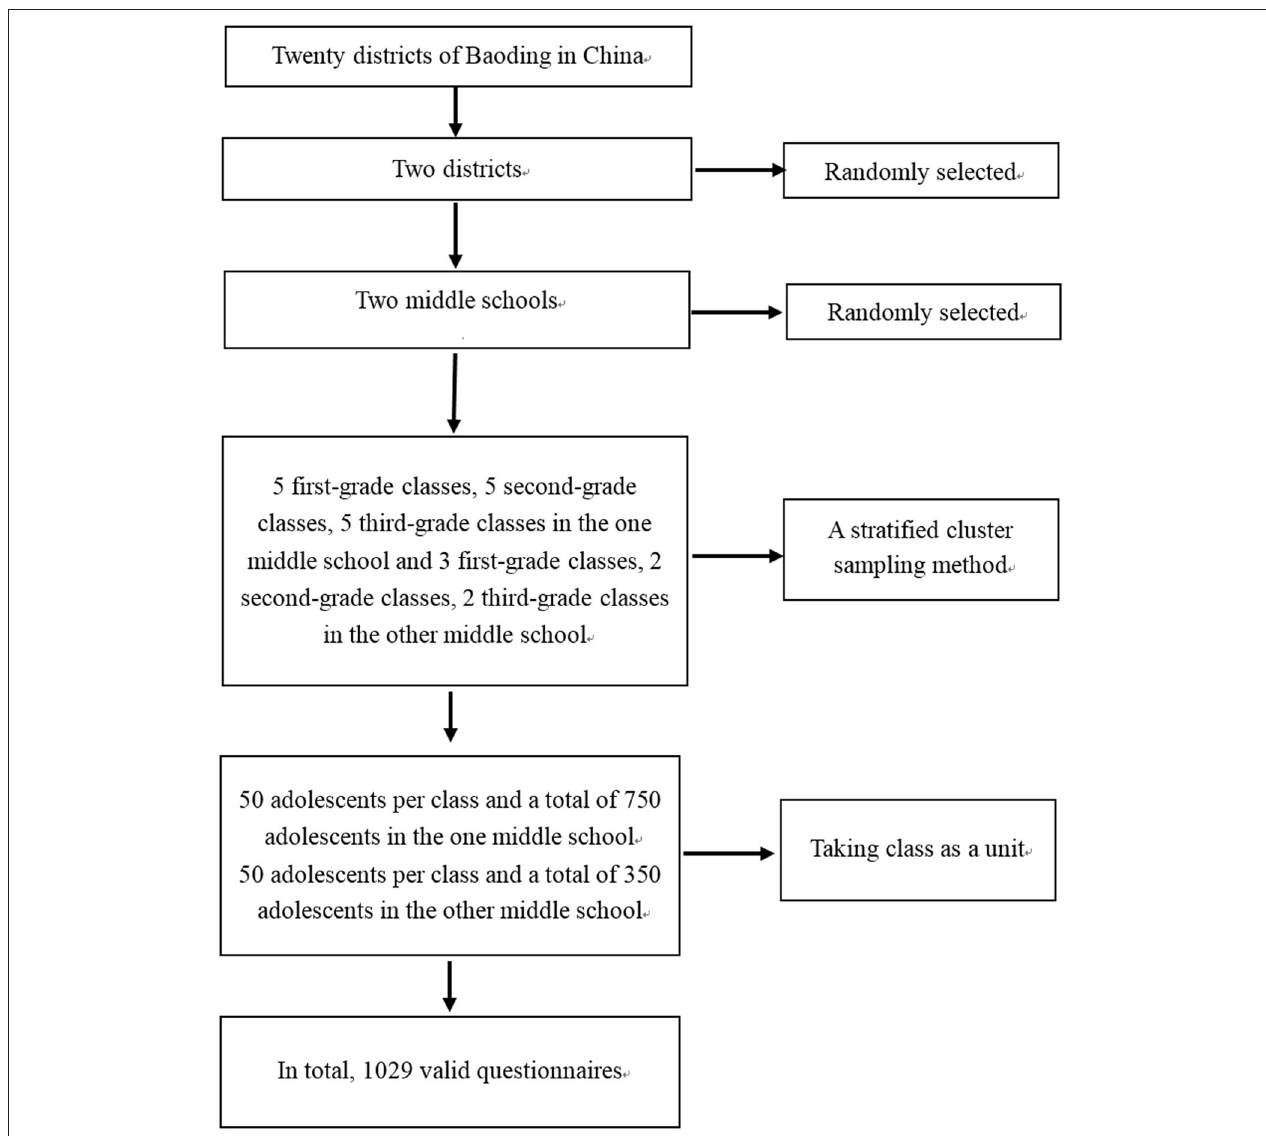
FIGURE 1 | Study participant flow diagram in this